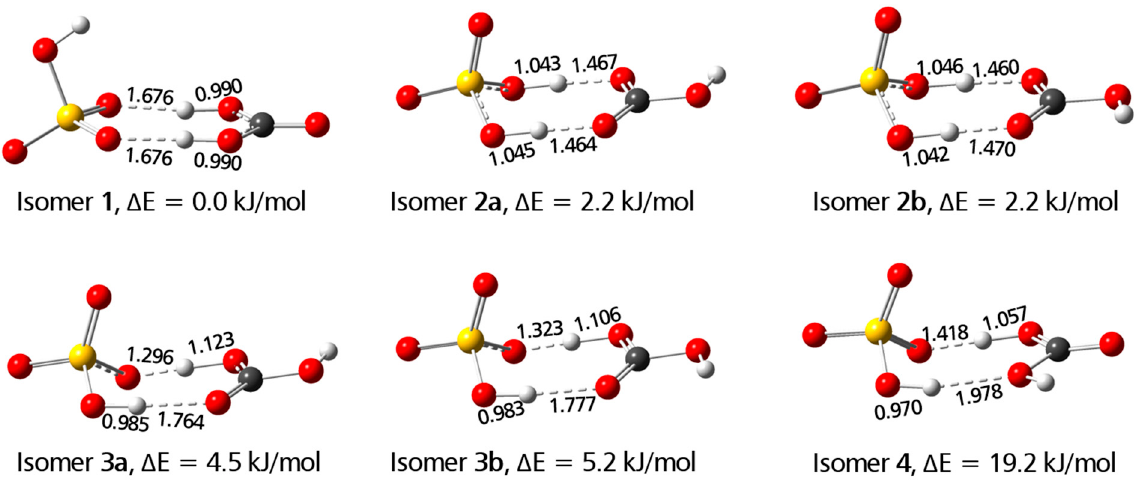
Figure 1. Optimized low-lying isomers of [H 2 CO 3 ·HSO 4 ] – at M06-2X/aug-cc-pVTZ level of theory. Isomers 2a and 2b are energy degenerate, and isomers 3a and 3b are also energy